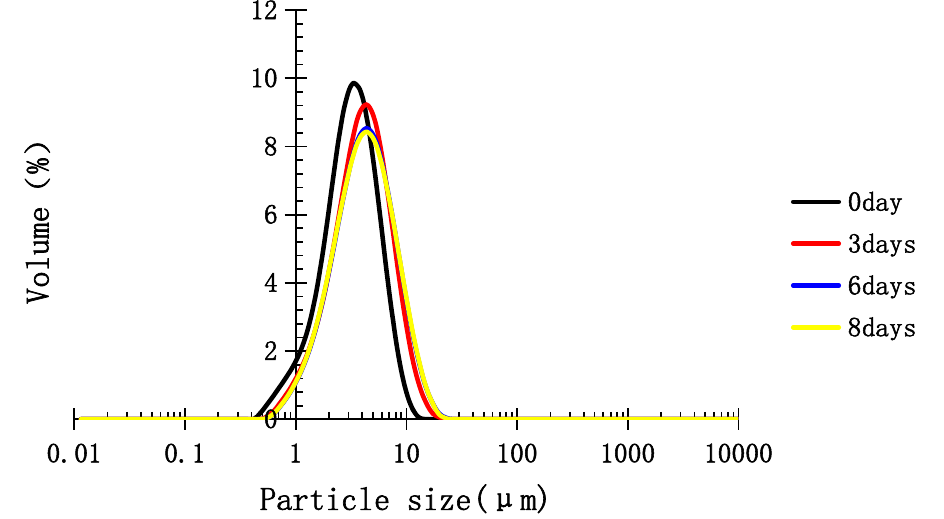
Figure 6. Particle size distribution (PSD) of MCT emulsion stabilized with TPC-A in the storage acceleration test at 60 ° C for a period of 8 days.